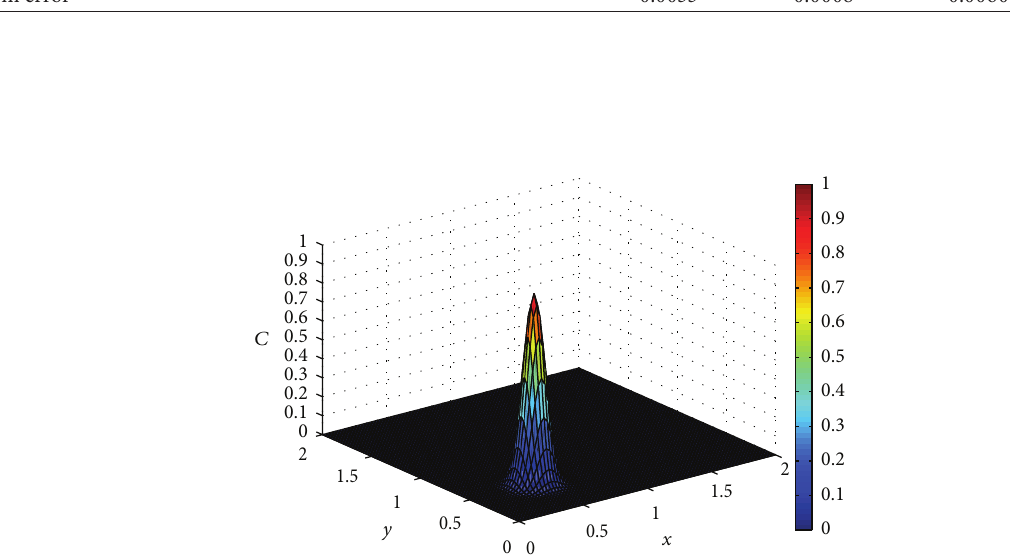
Figure 3: Initial Gaussian pulse of Example